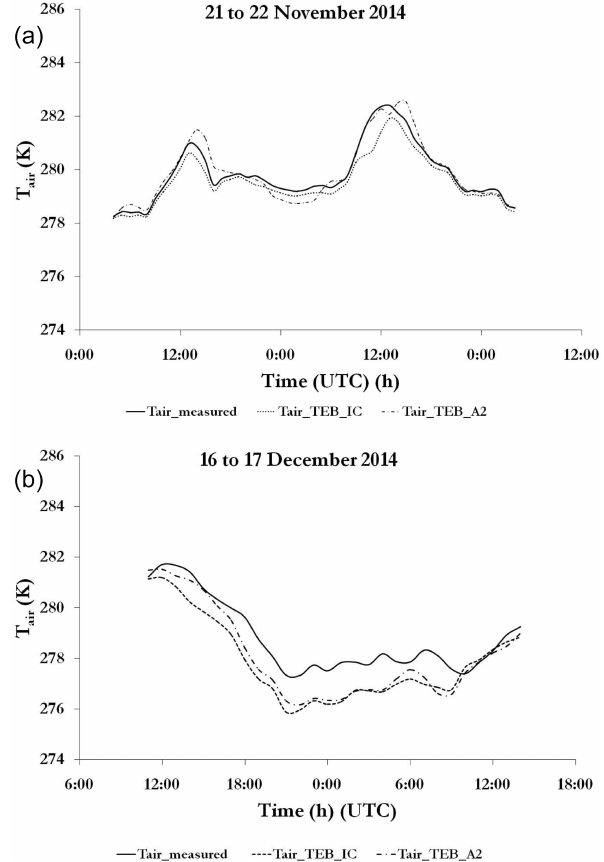
Figure 10. Comparison between air temperature from TEB in its initial configuration (Tair_TEB_IC), air temperature from TEB via the first approach (Tair_TEB_A1), air temperature from TEB via the second approach (Tair_TEB_A2) and air temperature from field data (Tair_measured) for the first (a) and for the second (b) experi-